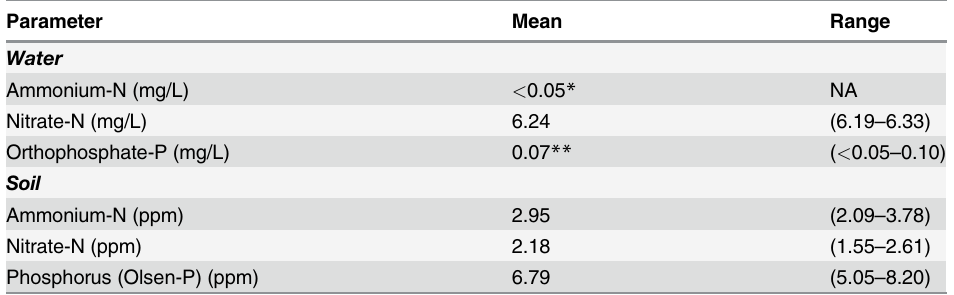
Table 1. Mean values and ranges of key nutrient levels of water and soil samples in the experimental